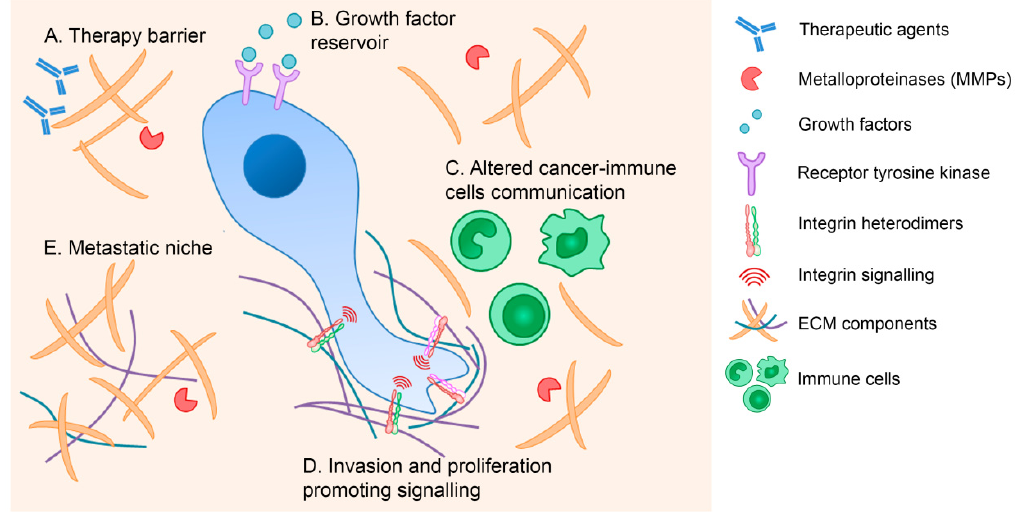
Figure 1. The extracellular matrix (ECM) contribution to cancer pathogenesis. The ECM mediates cancer development through several mechanisms, including formation of a physical barrier to anti-cancer drugs (A), provision of growth factor and cytokines reserves (B), alteration of immune cell responses (C), stimulation of integrin-dependent signaling that promotes invasion and proliferation (D), and establishment of an advantageous niche for metastatic cells (E).